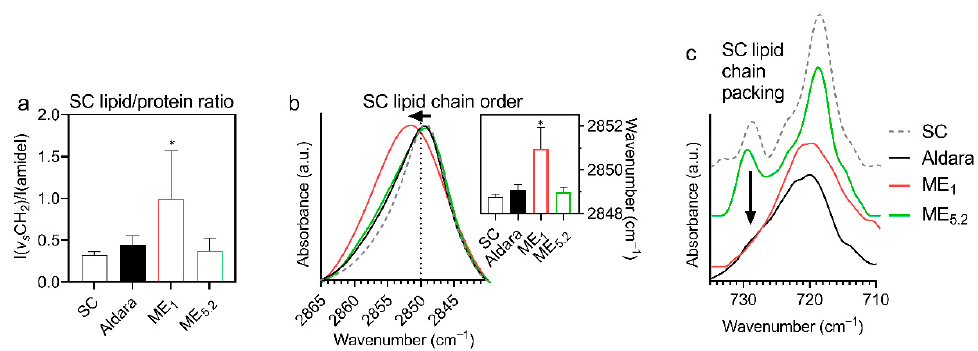
Figure 6. Infrared spectroscopy results of isolated human SC treated with selected formulations (means ± SD; n ≥ 8; * significant difference compared to untreated SC at p < 0.05). ( a ) Increased methylene band intensity (relative to the amide–mostly protein–bands) suggests penetration of ME 1 components with long chains (OA and/or PL) into the SC. ( b ) A shift to high wavenumbers and broadening of the methylene symmetric stretching band indicates more disordered lipid chains in ME 1 -treated SC than in control (for example, spectra and wavenumbers in the insert). ( c ) The disappearance of the ~730 cm − 1 component of a methylene rocking band in the SC treated with ME 1 and Aldara indicates a loosening of the tight orthorhombic SC lipid chain packing.